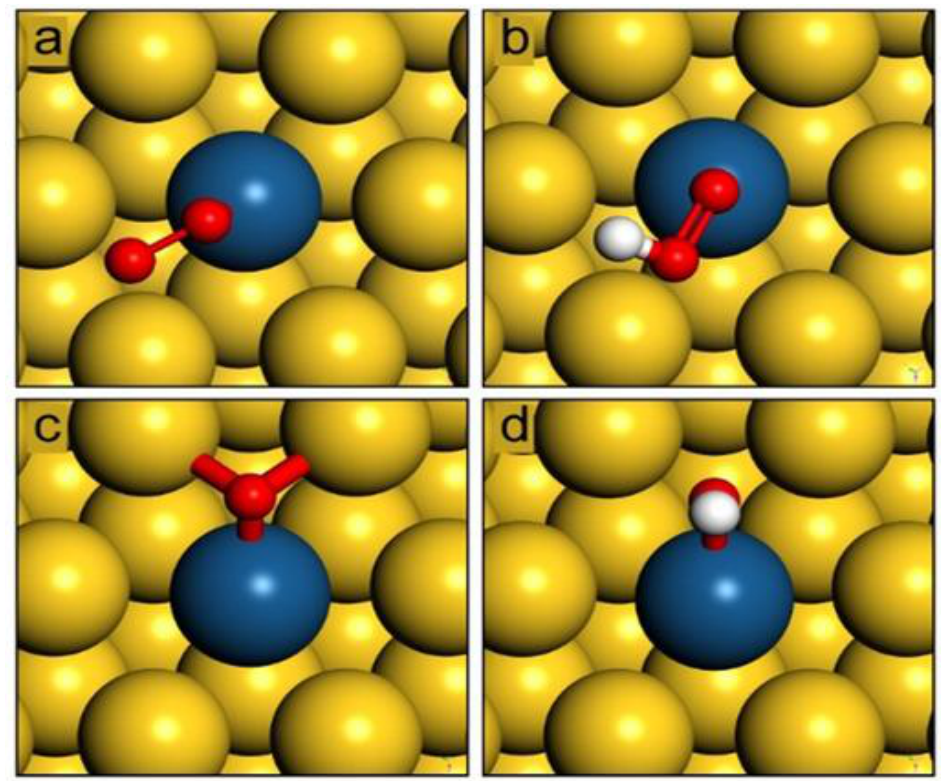
Figure 15. The most favorable adsorption geometries of ( a ) O 2 *, ( b ) OOH*, ( c ) O*, and ( d ) OH* on PtAu(111) as calculated by DFT. The adsorption geometry on PtAu(111) is typical of all SAAs in this study. (Reprinted with permission from [238]. Copyright 2021, John Wiley and Sons).